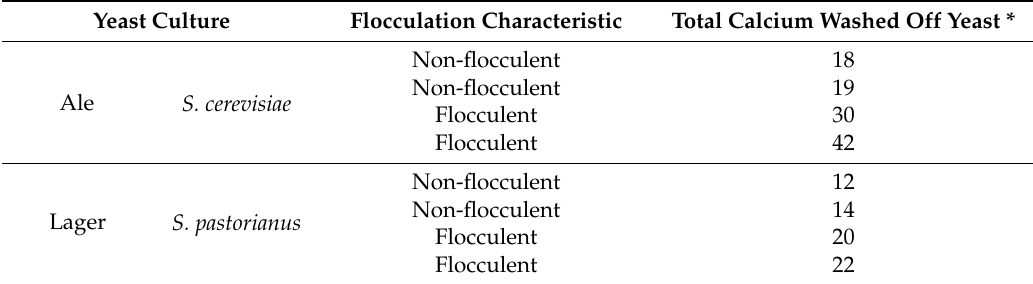
Table 2. Labelled (*) calcium removed from co-flocculent and non-flocculent cultures during de-flocculation washings